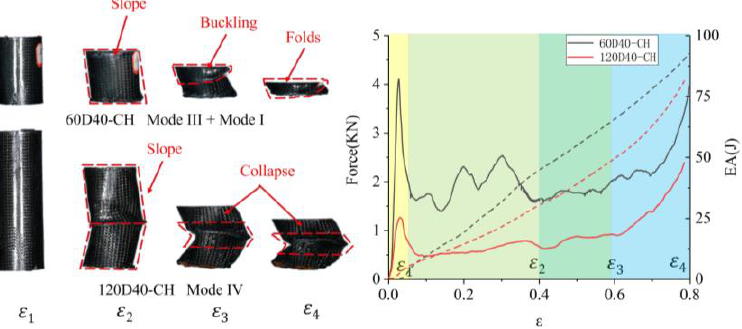
Figure 13. Failure mode and force–displacement curve of 60D4-CH and 120D40-CH.